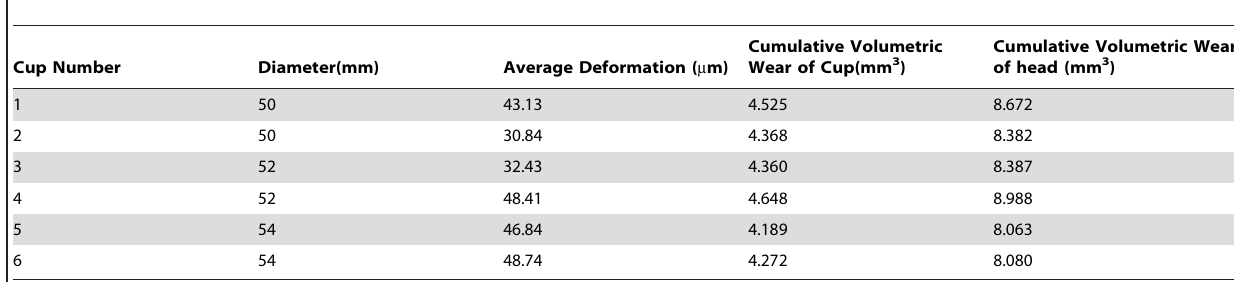
Table 2. Demographics of the deformation of each cup along with the corresponding wear value for each